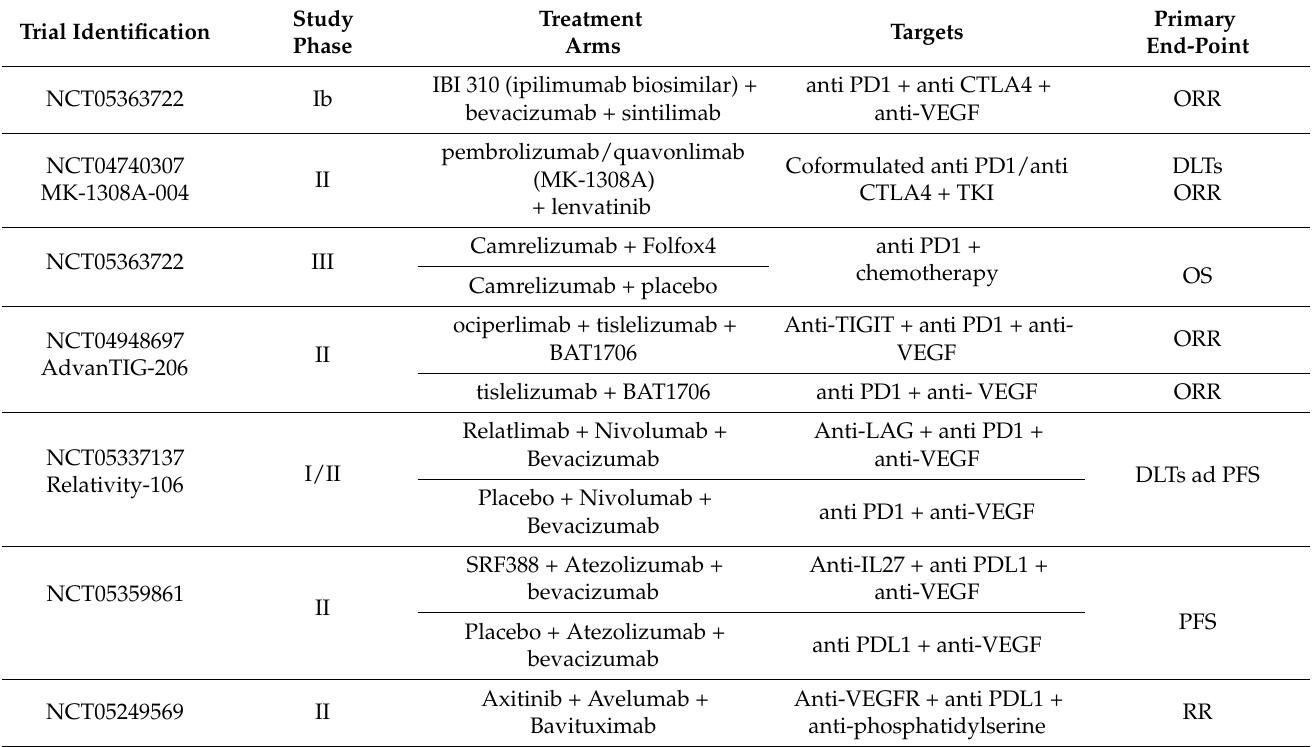
Table 3. Ongoing clinical trials of the triplet systemic strategy as first line for